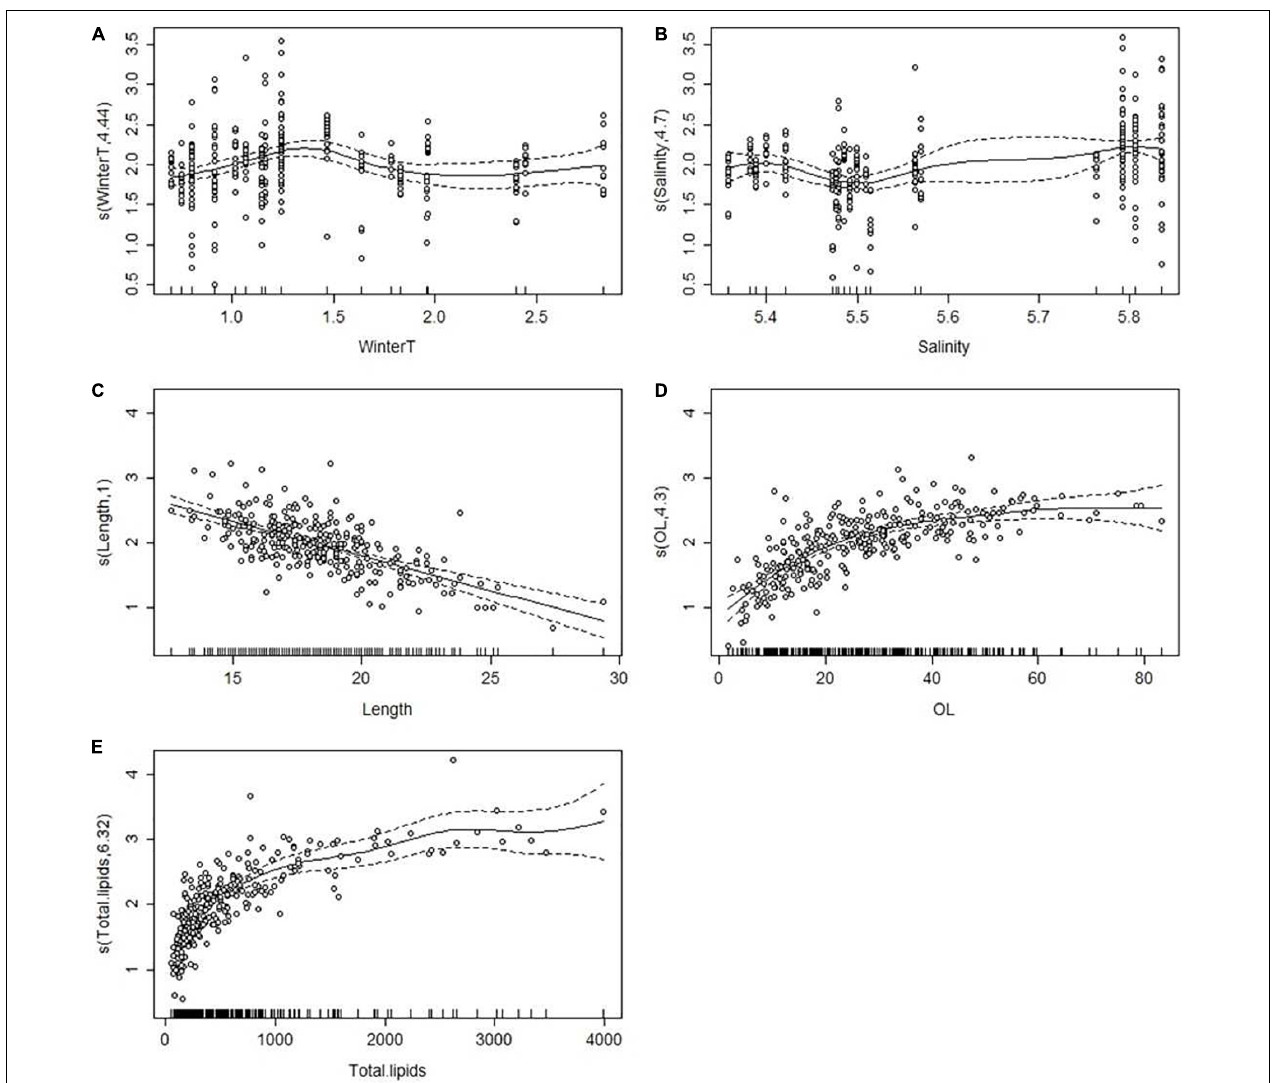
FIGURE 7 | Generalized additive mixed models B (A,B) and C (C–E) plots showing the partial effects of selected explanatory variables on the log-transformed content of lipids in the eggs ( µ g/egg). The tick marks on the x-axis are observed data points. The y-axis represents the partial effect of each variable. The dotted lines indicate the 95% confidence intervals. WinterT = water temperature ( ◦ C) in January-April, OL = percentage (%) of ovarian lipids of the total lipids of the female, Total lipids = total content of lipids (mg) in herring females. See text for further